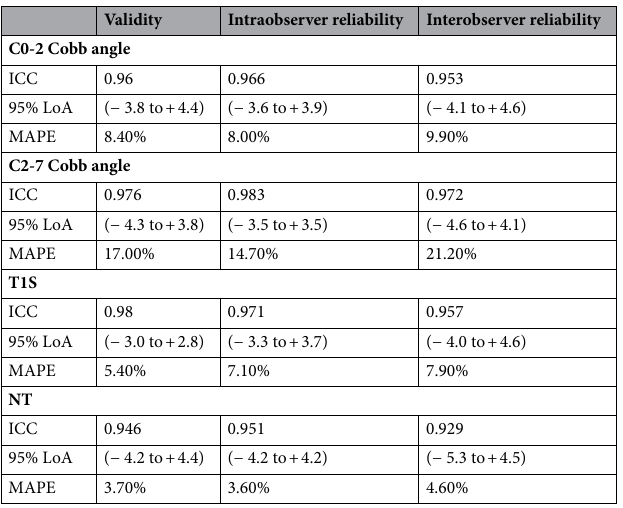
Table 1. The ICC, 95% limits of agreement (LoA) and mean absolute percentage error (MAPE) of validity, intraobserver and interobserver reliability of the four